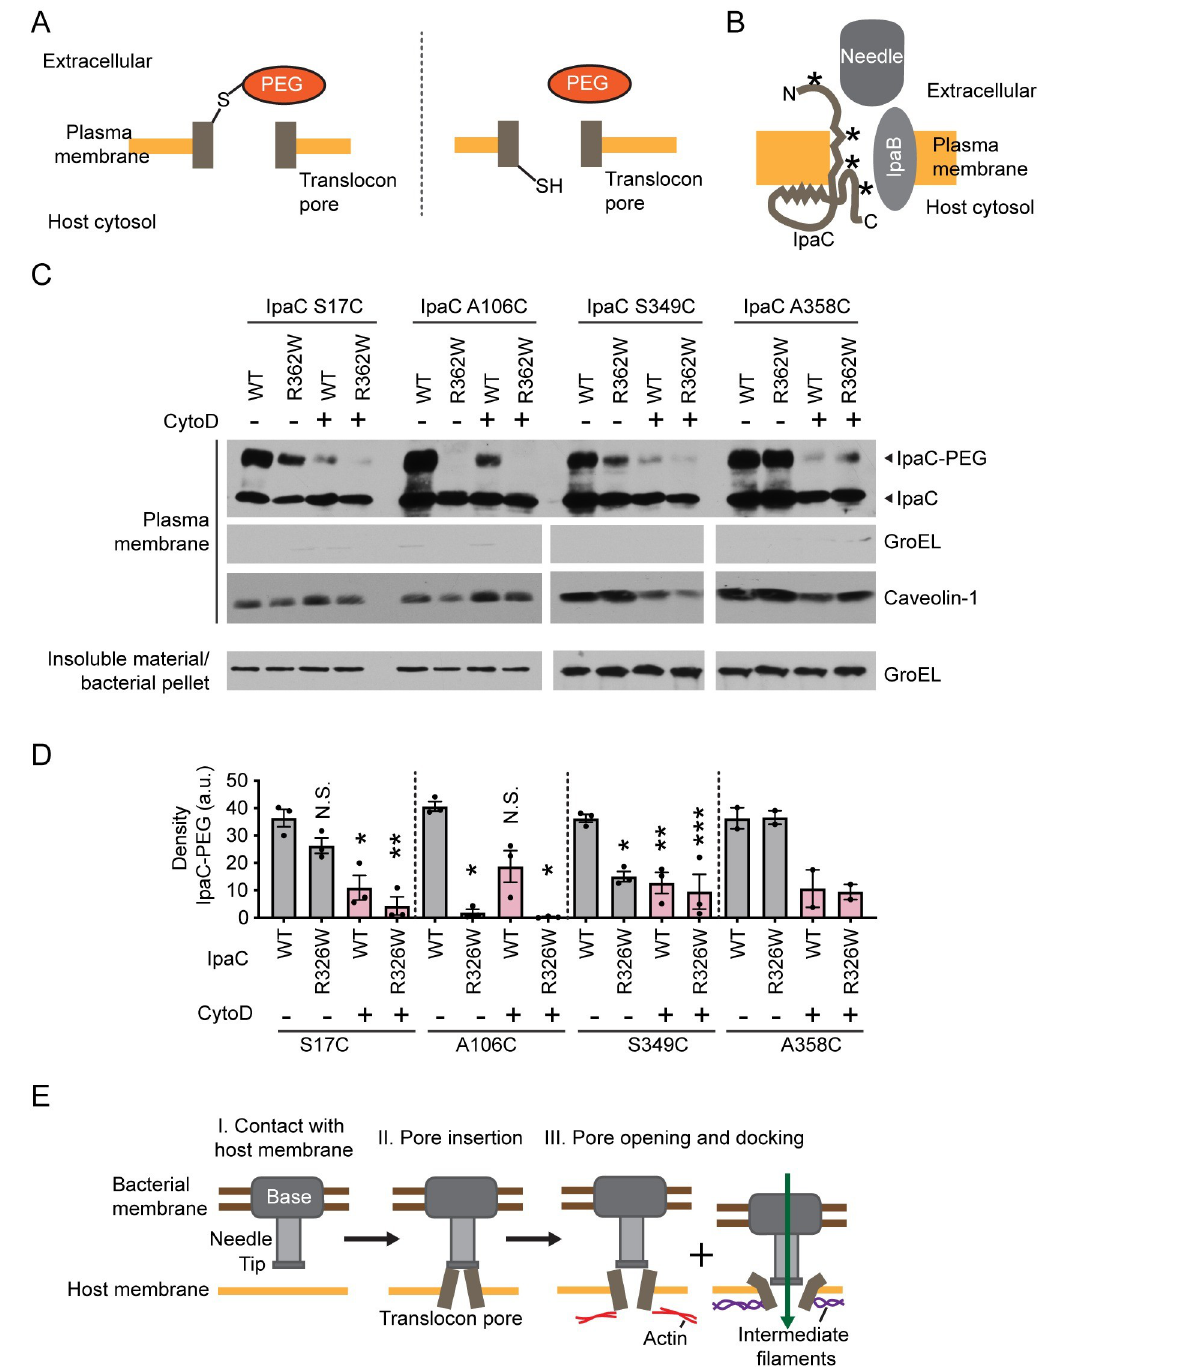
Fig 3. Actin polymerization induces conformational changes to the translocon pore. (A) Schematic depiction of extracellular accessibility assay. PEG5000-maleimide (PEG) covalently binds sulfhydryl group of cysteines that are accessible from the outside of the mammalian cell; it is membrane-impermeant and too large to fit through the translocon pore. (B) Schematic of topology of IpaC (from [40]). � , location of cysteine substitutions; top to bottom: S17, A106, S349, A358. (C-D) Effect of CytoD on PEG5000-maleimide labeling of sulfhydryl groups in single cysteine substitution derivatives of WT IpaC or IpaC R362W. S . flexneri infection of HeLa cells in the presence or absence of CytoD at a MOI of 500. (C) Representative western blots. WT, WT IpaC backbone; R362W, IpaC R362W backbone; IpaC-PEG, IpaC labeled with PEG5000-maleimide; IpaC, unlabeled IpaC; GroEL, bacterial cytosolic protein; caveolin-1, eukaryotic plasma membrane protein. Data are representative of two to three independent experiments. (D) Quantification of the IpaC-PEG band from experiments represented in panel C. For each IpaC cysteine substitution,